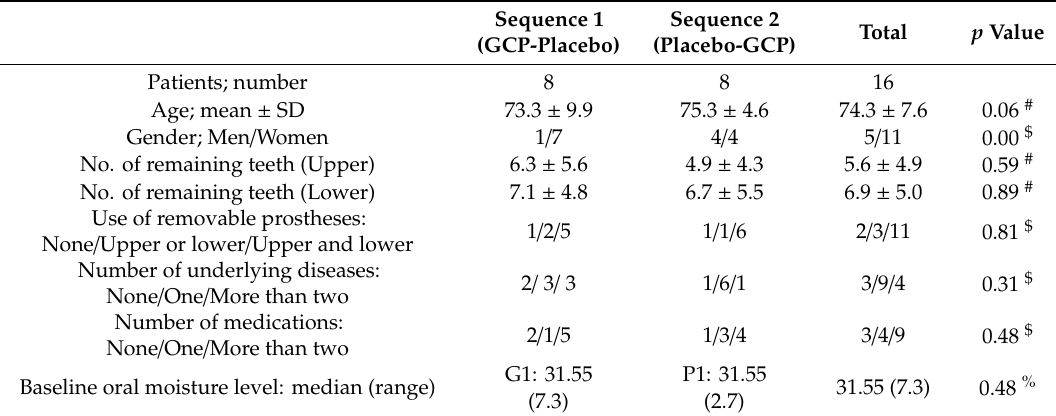
Table 1. Outline of study participants at baseline.